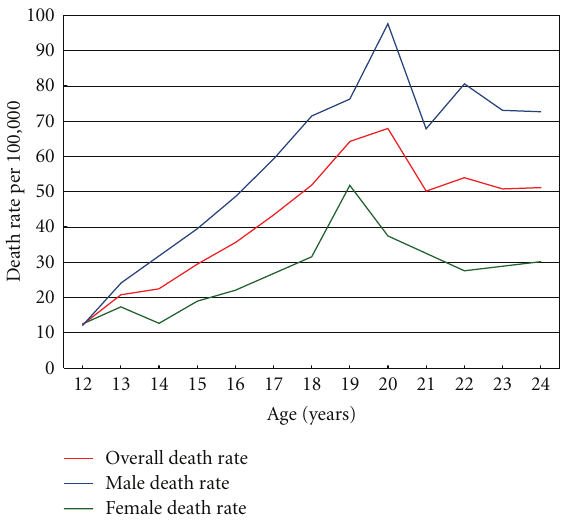
Figure 3: Death rates by age per 100,000 youth by cause category (disease-related, injury, interpersonal violence, suicide/self